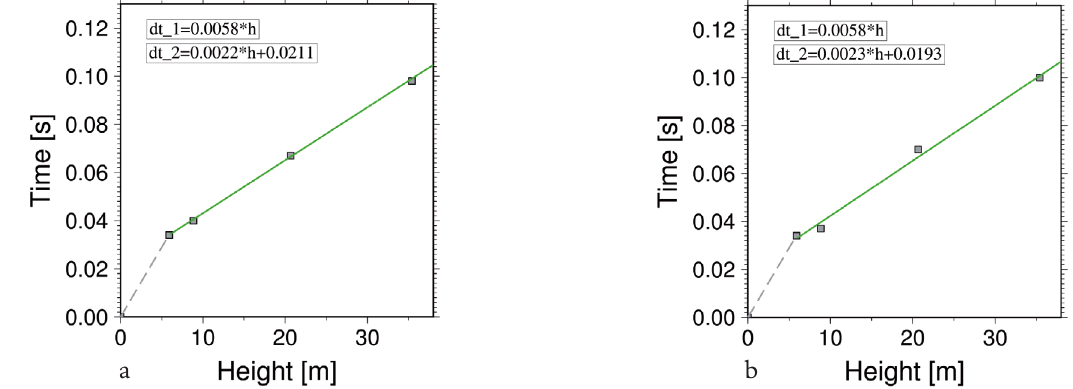
Figure 15. Travel times between the pulses of up and down-going waves at different floors versus the distance of the considered sensor to the sensor at the roof. The slope of the green and the dotted gray lines correspond to the slownesses for a certain layer. (a) x and (b) y